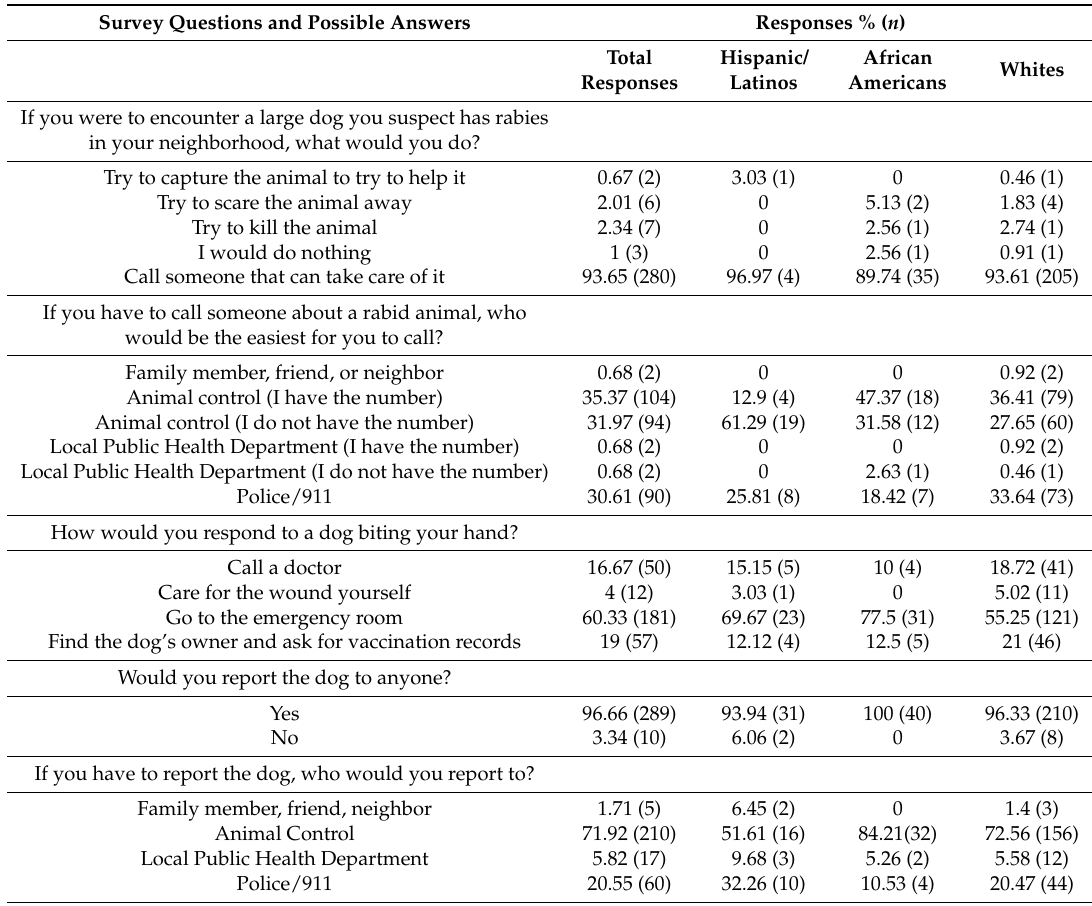
Table 2. Frequency of answers regarding rabid animal reporting and first response after rabies exposure in Greensboro, North Carolina, 2009.